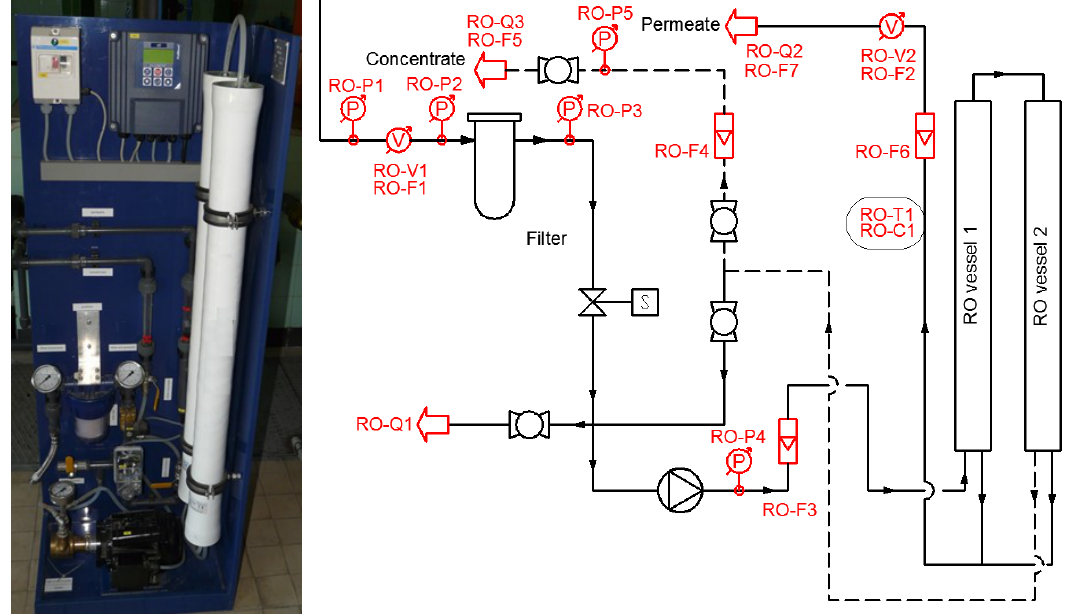
Figure 2. Small scale reverse osmosis (RO) unit (measurement points: F = flowrate; C = conductivity; P = pressure; Q = sampling; T = temperature; V = volume).